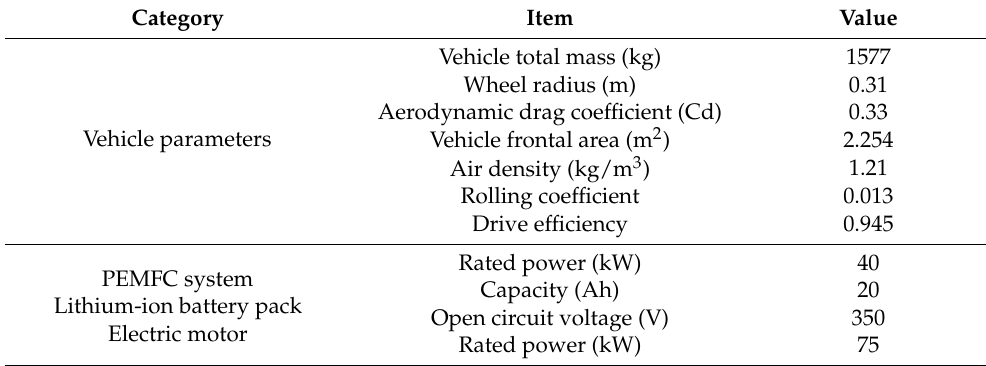
Table 1. Vehicle and powertrain